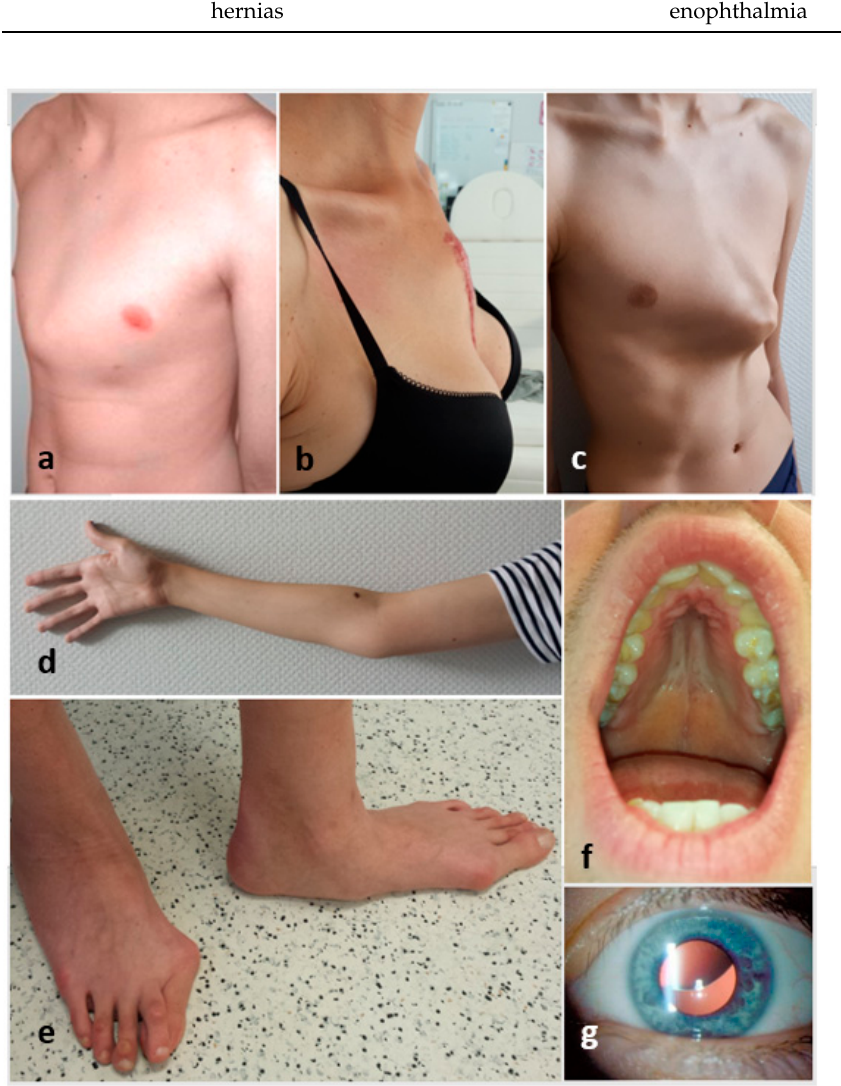
Figure 3. The figure shows some of the red flags described above: ( a – c )—pectus carinatum, ( d )— reduced elbow extension, ( e )—hindfoot deformity, ( f )—gothic palate and ( g )—lens subluxation.